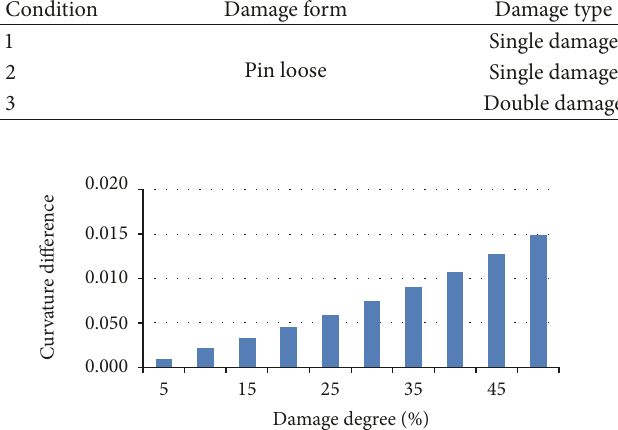
Figure 6: Relationship between the difference of the HHT marginal spectrum curvature and the damage degree.